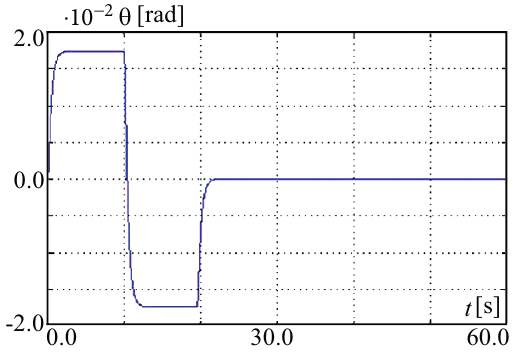
Fig. 13. Angle of rotation θ( t ) about the OY -axis Similarly to the previous case (Fig. 11), the rotation angles φ and ψ vary slightly in time causing a small dis- placement along the OY -axis. The object has been accel- erated along the OX -axis, and then slowed down to as- sume a particular position.